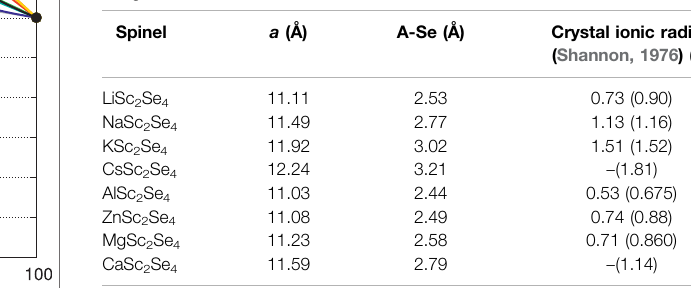
TABLE 1 | Lattice constants a and charge carrier selenium distances A-Se of the ASc2Se4 spinel structures. Crystal ionic radii for the charge carriers in tetrahedral environment are listed (Cs and Ca are typically not observed in tetrahedral coordination). For comparison the values for octahedral environment are given in